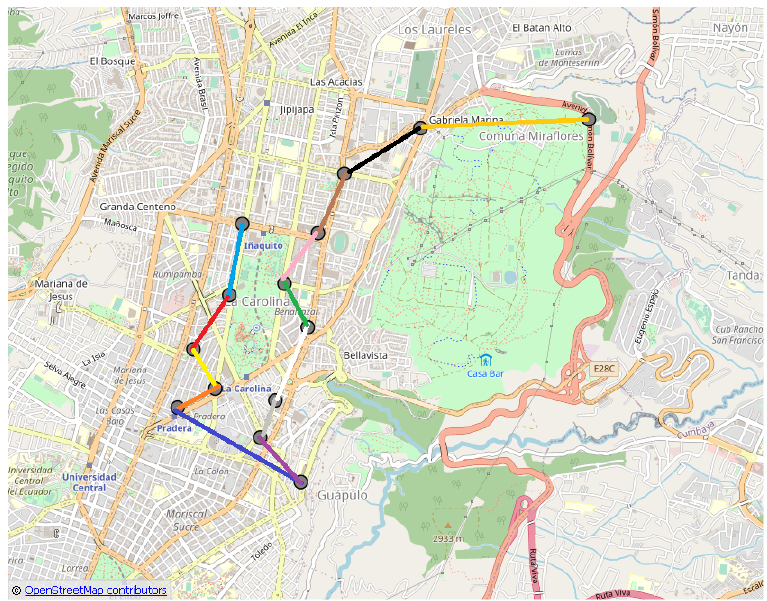
Figure 16. Way-points sequence obtain by Expert (gray circles are way-points and color lines are the routes, Table 3).